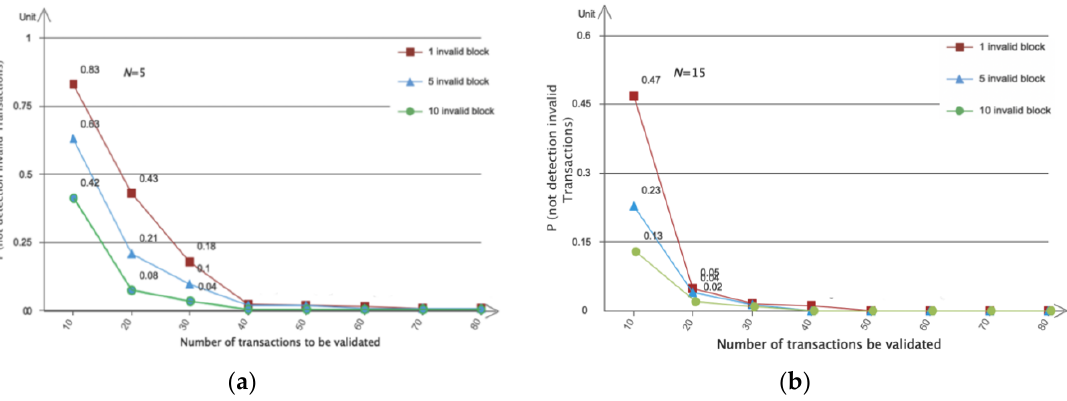
Figure 6. Probability of not detecting invalid transactions in a block. Total = 80 and N = 5, 15 respectively: （ a ） N = 5; （ b ） N = 15 .